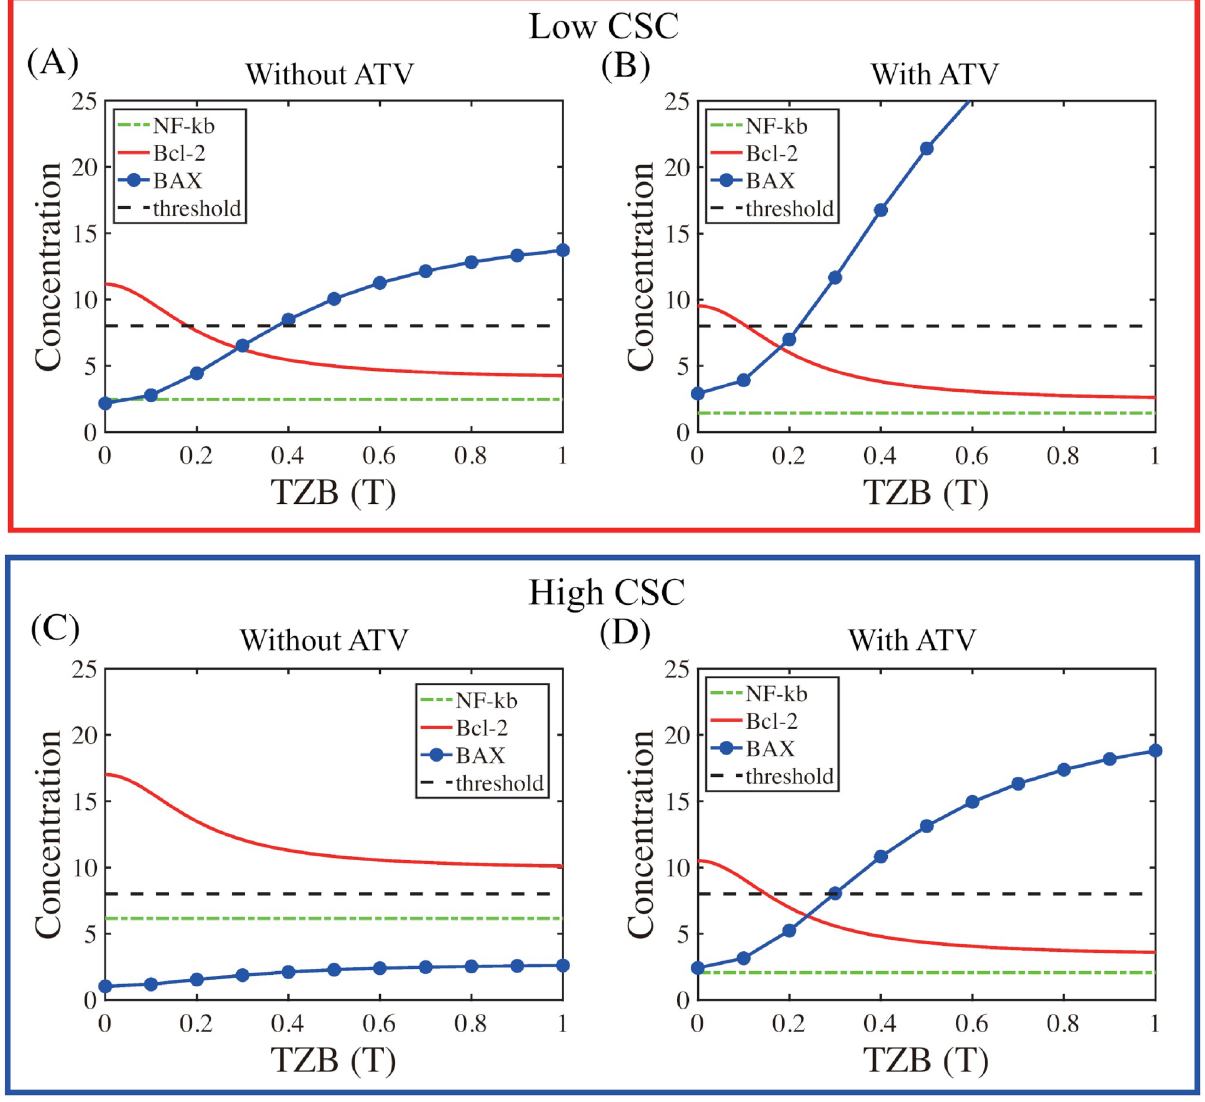
Fig 3. The effects of TZB on intracellular variables in response to low (A-B) and high (C-D) CSC density. (A,B) Steady states of concentrations of NF κ B, Bcl-2, and BAX in response to TZB treatment in the absence (A) and presence (B) of ATV when the CSC density is low. (C,D) Responses of intracellular variables without (C) and with (D) ATV treatment when the CSC density is high. � threshold value = dotted line.